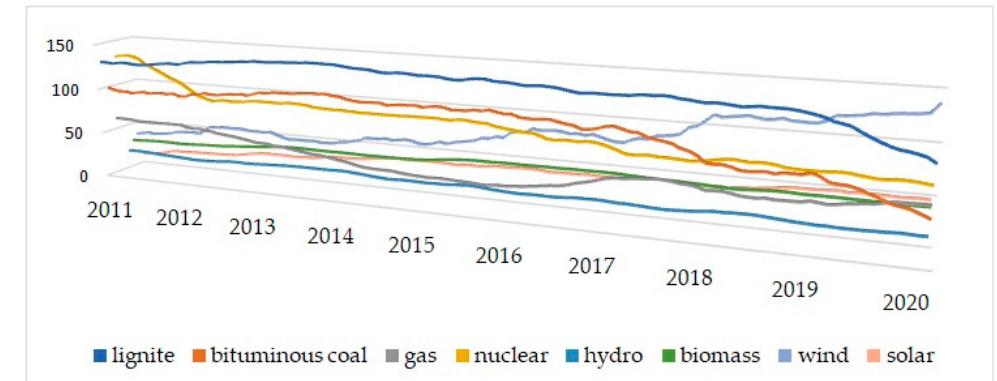
Figure 12. Electricity generation in Germany (TWh) [49].